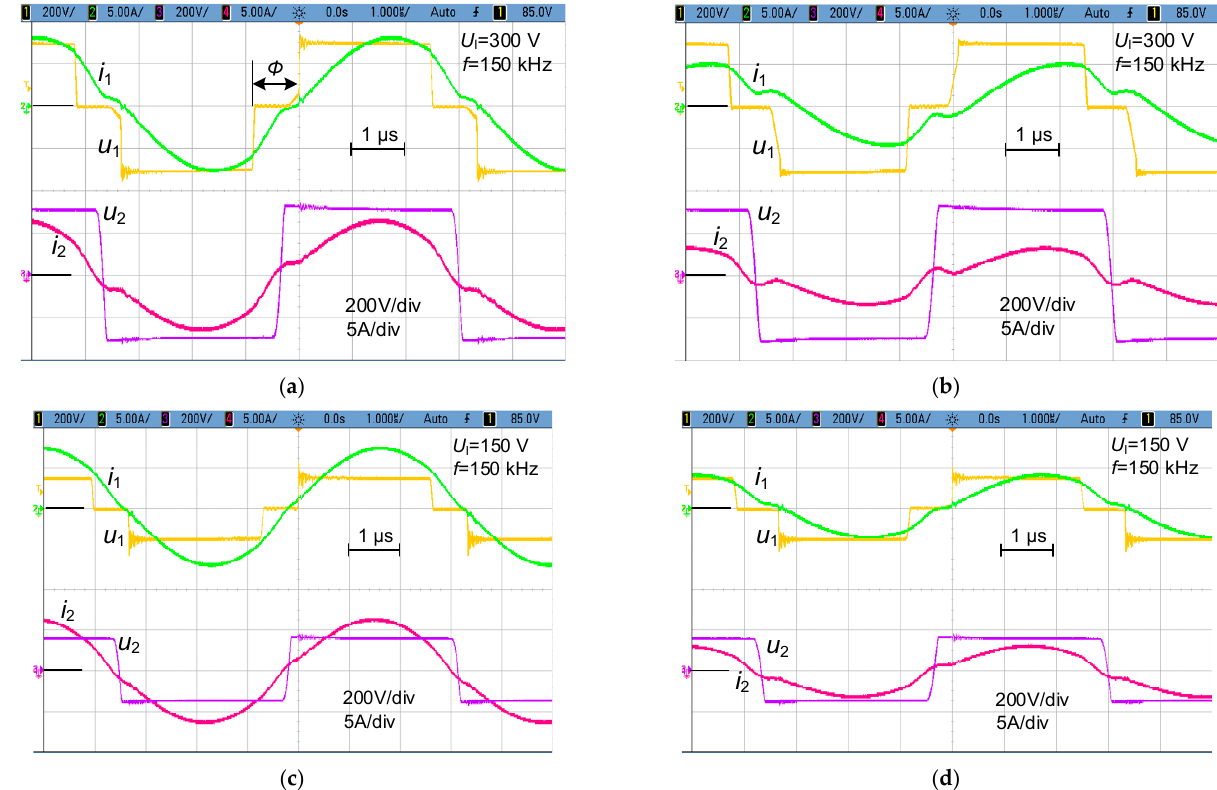
Figure 12. Voltage and current waveforms of primary-side inverter and secondary-side rectifier in closed-loop operation: